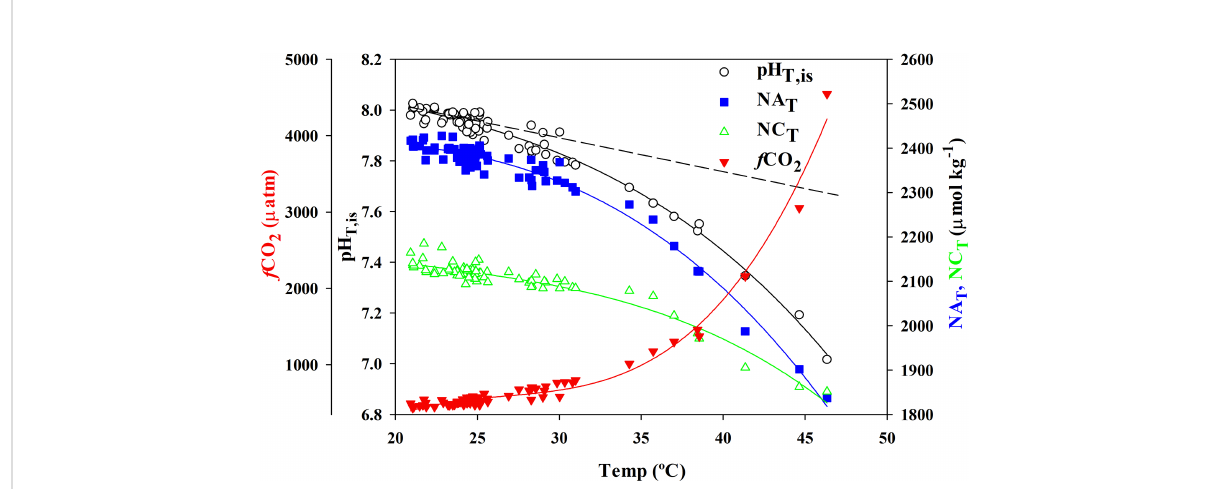
FIGURE 6 Relationship with temperature for pH T,is (black open dots), normalized to a constant salinity of 37 for A T (NA T , blue squares) and C T (NC T , green open triangles), and f CO 2 (red triangles). Lines represent the third-degree polynomial fi tting of the data. The black dashed line is the expected pH dependence with temperature (Takahashi et al.,